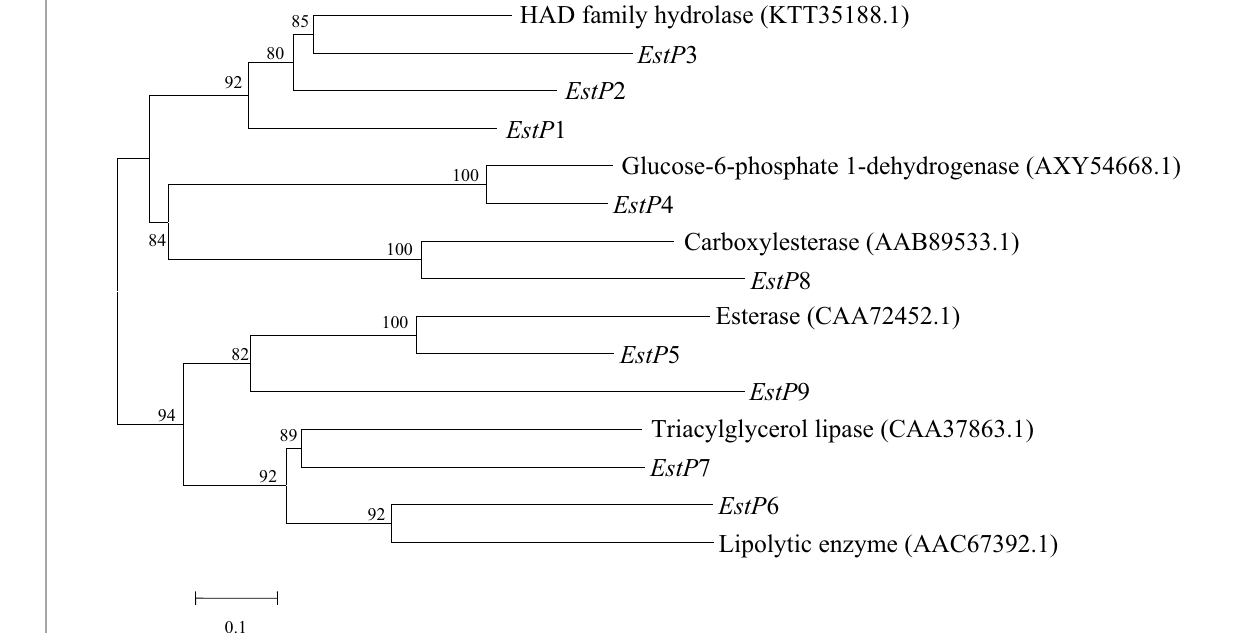
Fig. 5 The evolutionary relationship between nine predicted proteins in the strain CD-9 genome and the reported proteins that degrade pyrethroids